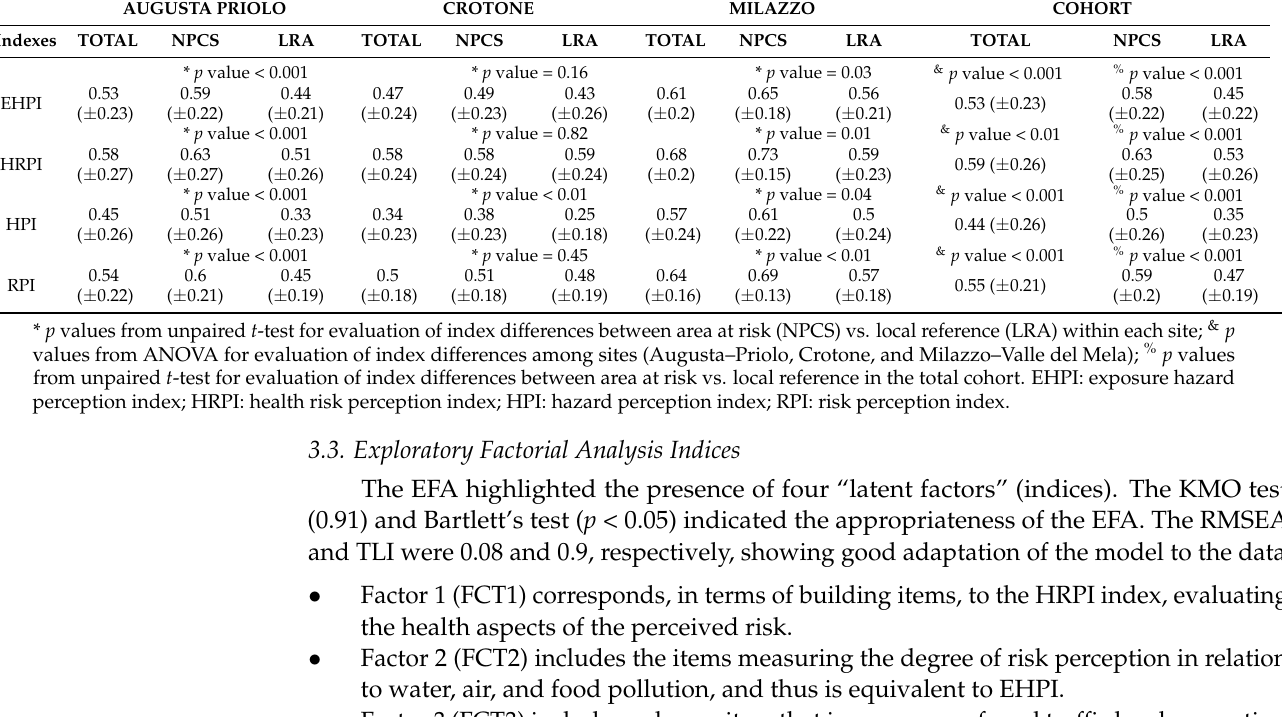
Table 3. Descriptive characteristics of risk perception indices between the three national priority contaminated sites. AUGUSTA